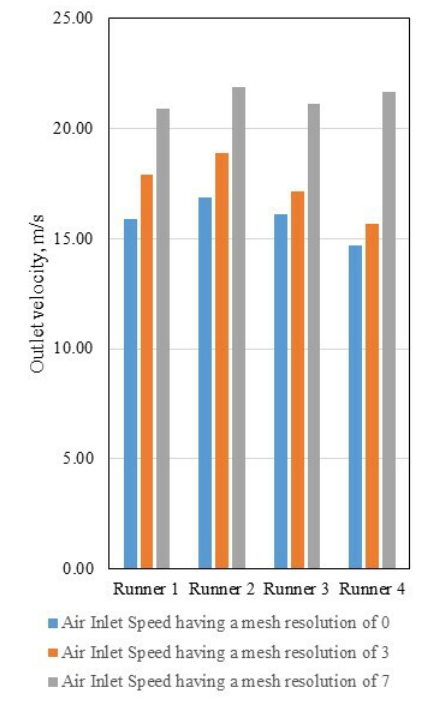
Fig. 8. Outlet velocity at inlet velocity of 50 m/s with varied mesh resolution